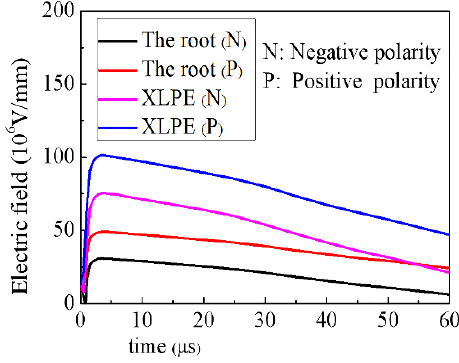
Figure 14. Variation of the electric field strength with respect to time in the lightning pulse process. Materials 2018 , 11 , x FOR PEER REVIEW 12 of 14